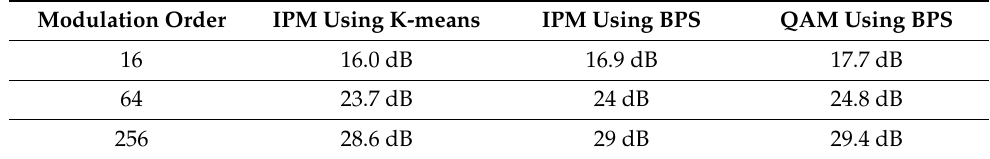
Table 2. SNR of different approaches at HD-FEC